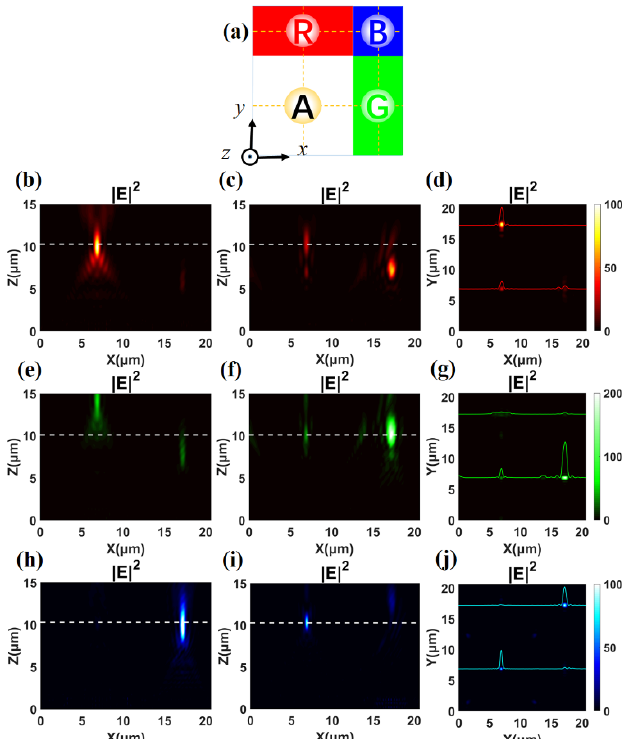
Figure 6. ( a ) Schematic diagram of the theta modulation meta ‐ surface with four unequal areas. ( b – d ) Electric field intensity profiles in the focal region of xz plane with y = 17.20 μ m, xz plane with y = 6.88 μ m, and xy plane z = 10.28 μ m, respectively, at λ = 700 nm. ( e – g ), ( h – j ) Corresponding analysis